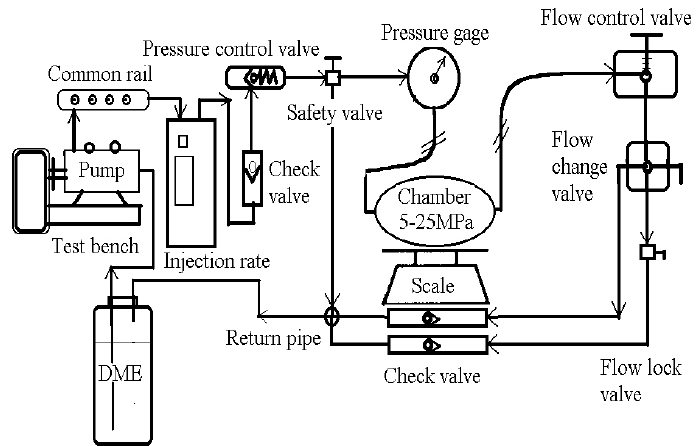
Figure 1. Schematic of the experimental setup.